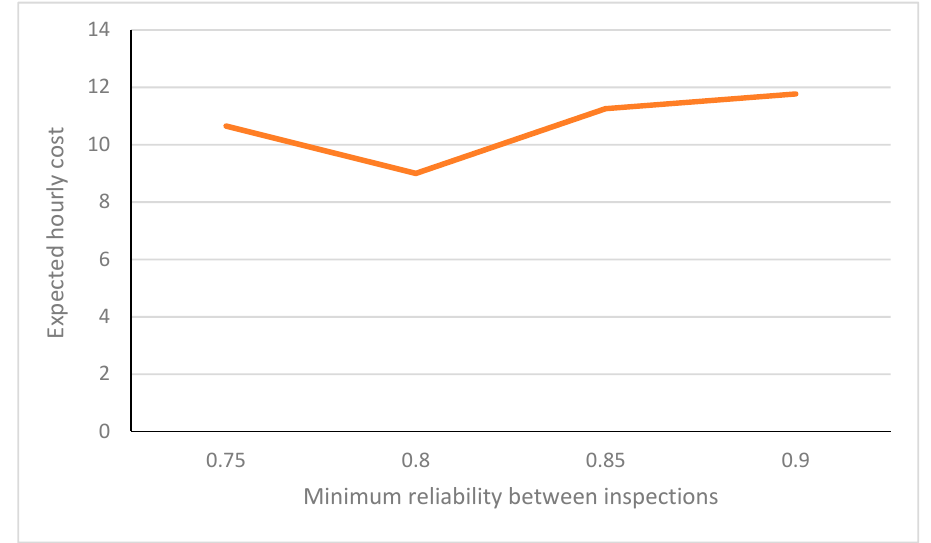
Figure 4. Variation of